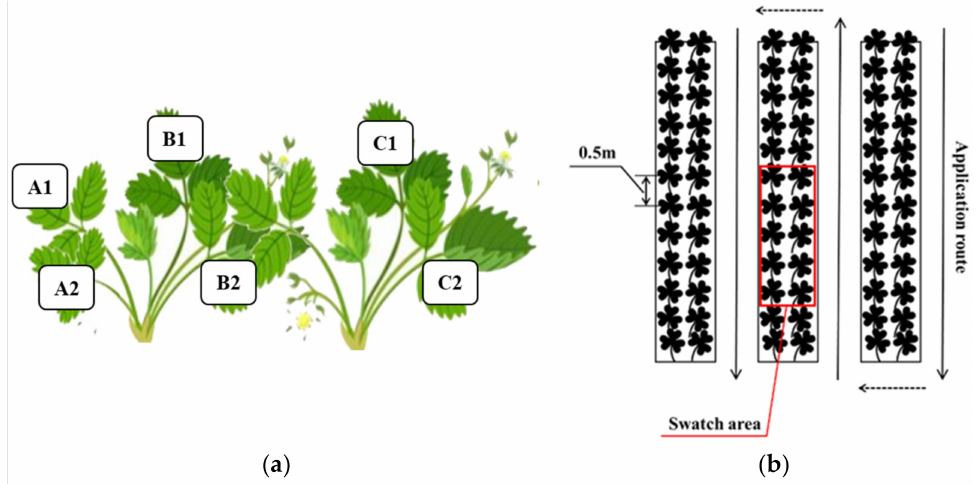
Figure 4. Schematic diagram of the field test and canopy division: ( a ) division of the strawberry canopy; ( b ) experimental site and the route of application.